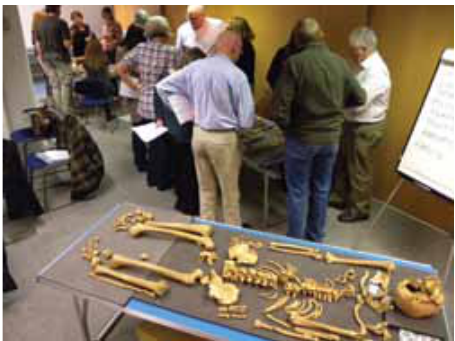
Fig. 1: ‘Thames at War’ workshop (photo N. Cohen).